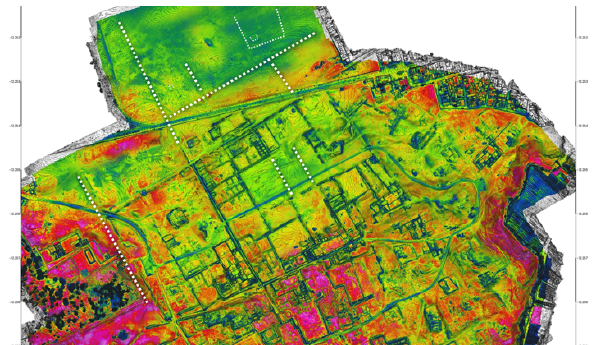
Figure 12 . Example of visualization of potential buried structures (white tilled lines)